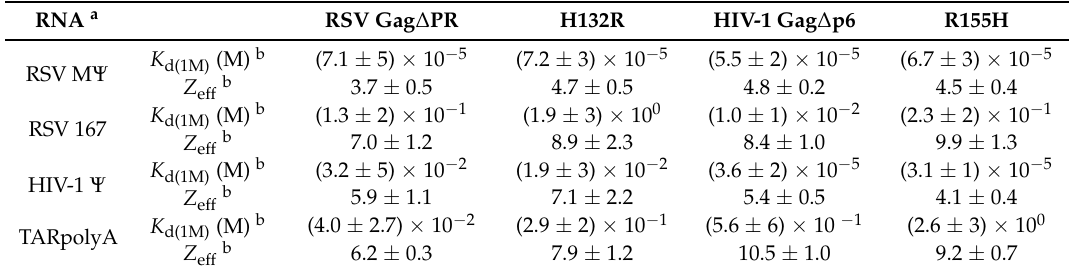
Table 2. Binding parameters determined from FA salt-titration assays of wild-type (WT) and chimeric Gag constructs.